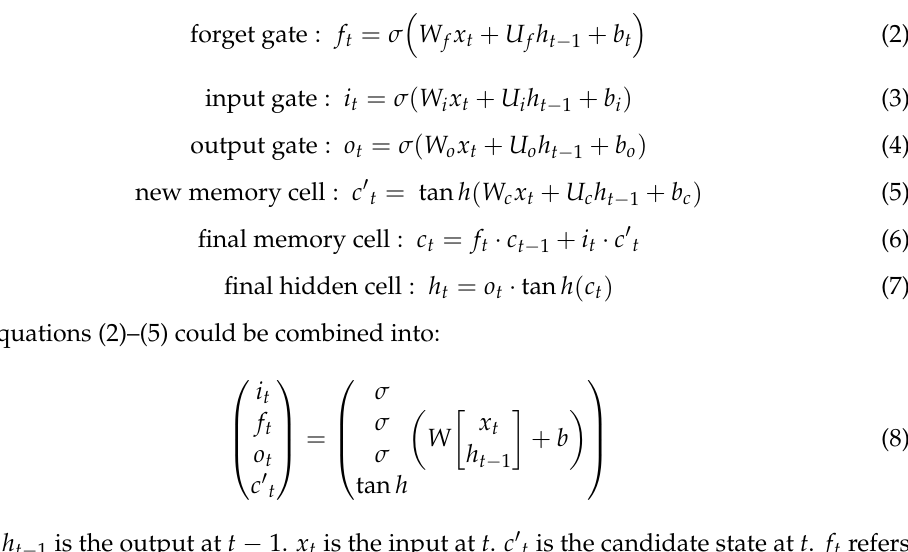
Figure 4. Structure diagram of LSTM CELL, including forget gate, input gate, and output gate.